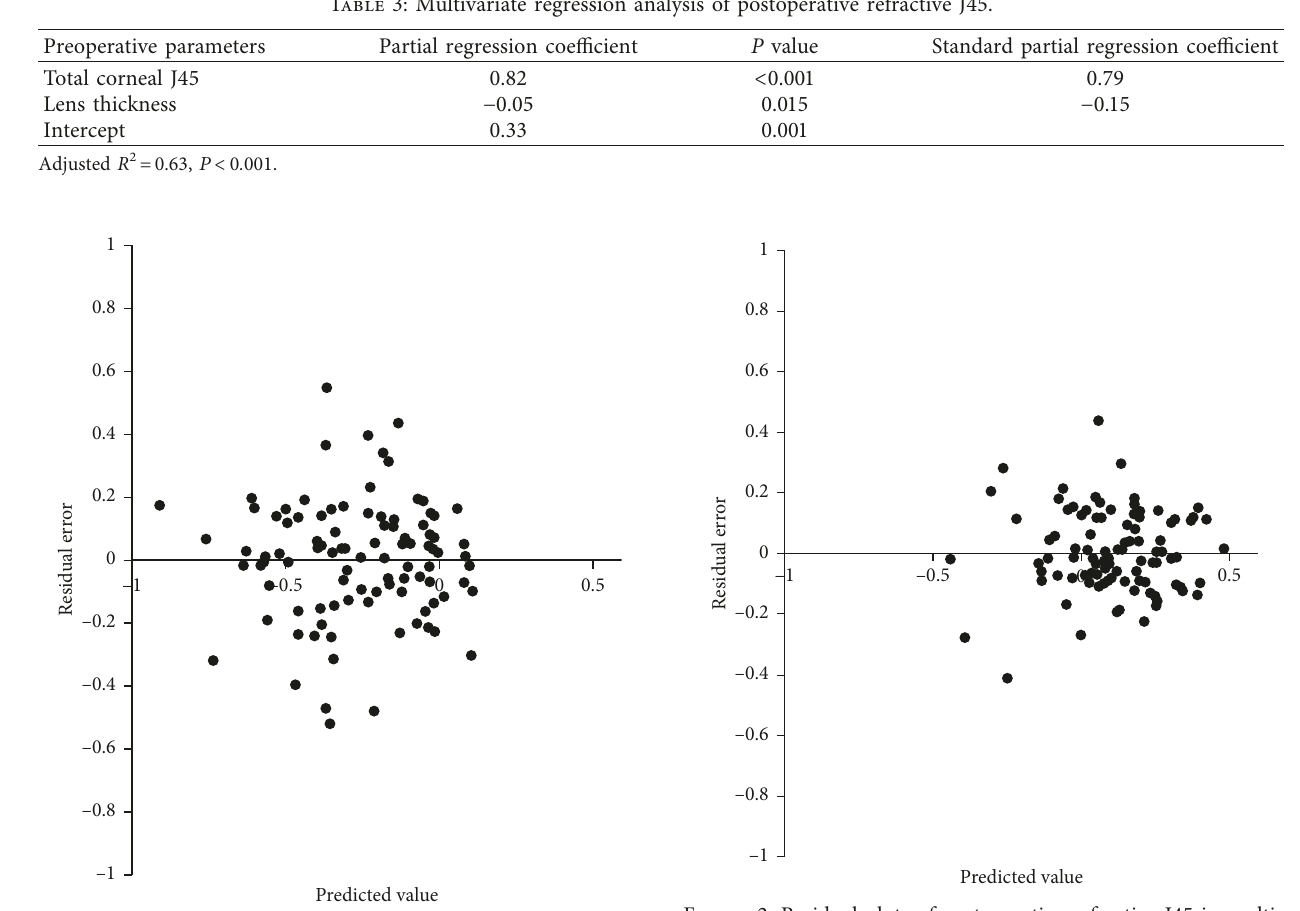
Figure 1: Residual plots of postoperative refractive J0 in multi- variate regression analysis.